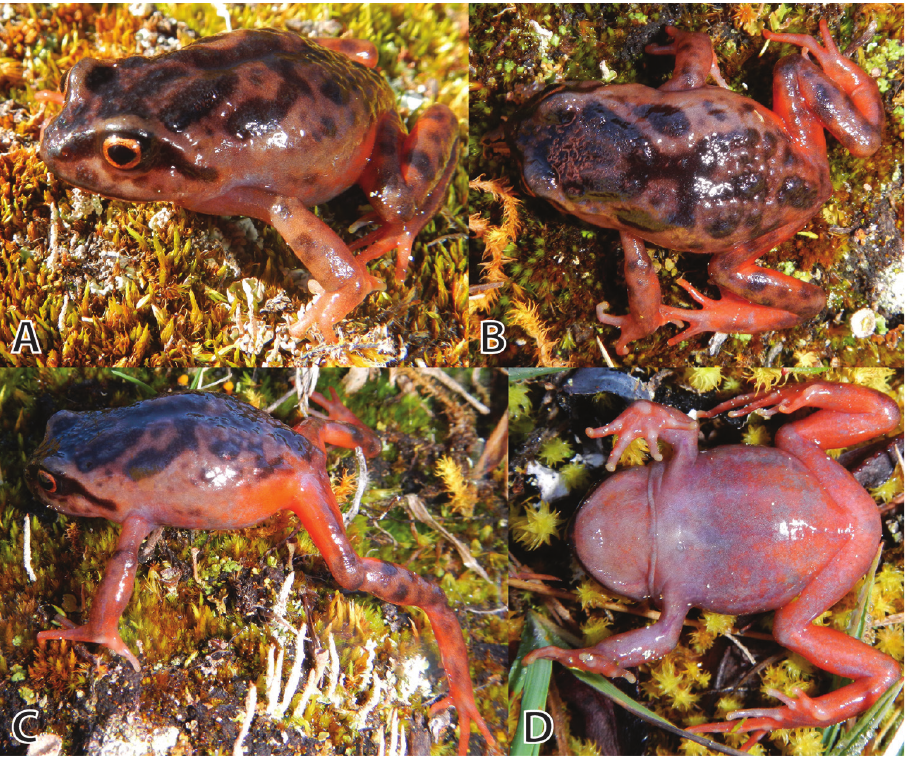
Figure 5. Life male holotype (MUSM 31183, SVL 32.5 mm) of Phrynopus inti sp. n. in dorsolateral view ( A ), dorsal view ( B ), flanks, groin, anterior surfaces of thighs ( C ), and ventral view ( D ). Photos by E.